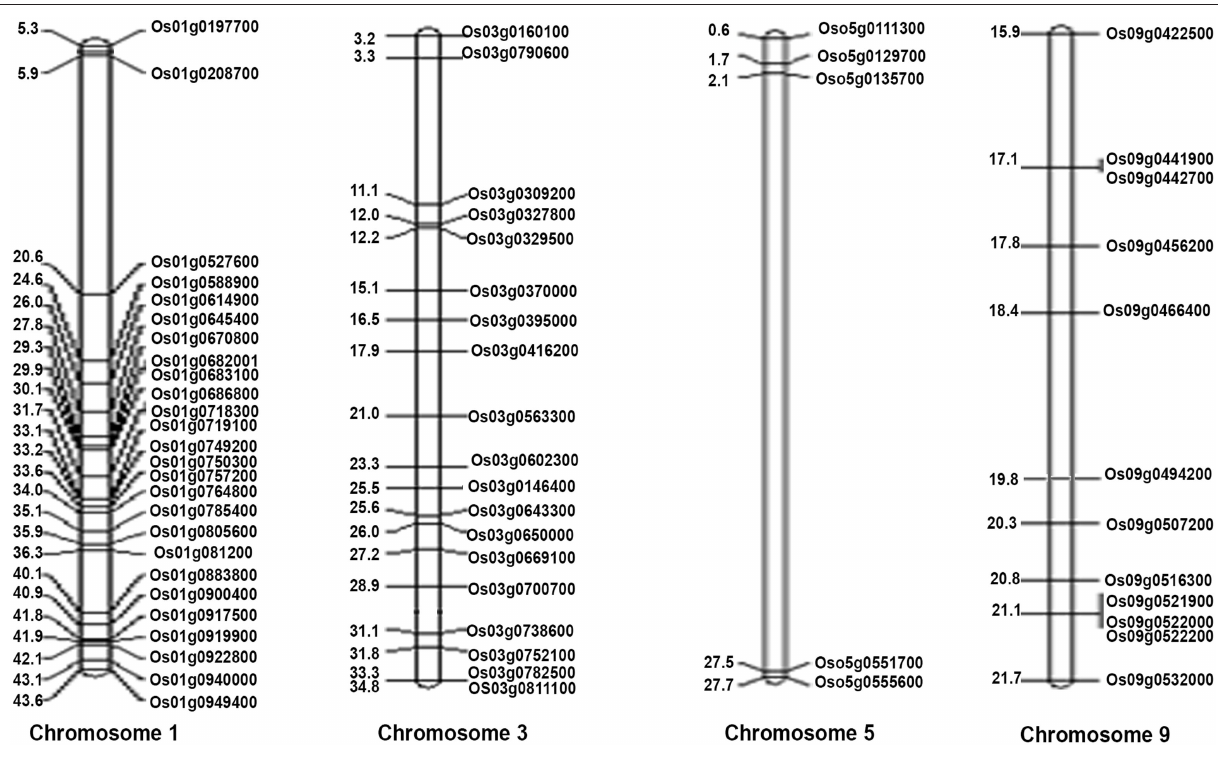
FIGURE 8 | Physical positions of the 62 NUE-candidate genes on four rice chromosomes (chromosomes 1, 3, 5, and 9). Gene ID is given on the right side of the map, and the physical location of genes is given on the left side of the map (in